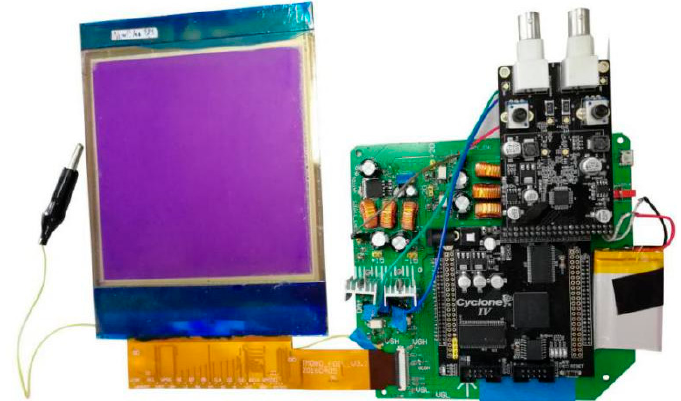
Figure 6. The driving system of the thin film transistor (TFT)-EWD. Table 1. Parameters of the TFT-EWD.